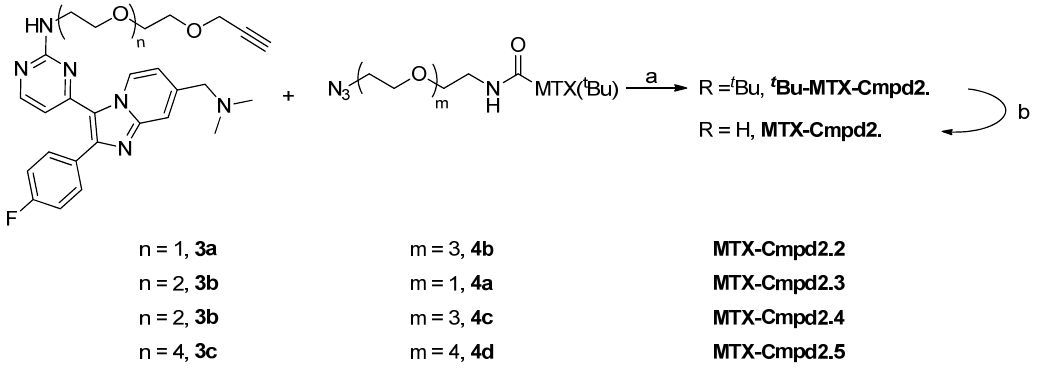
Scheme 3. Hüisgen 1,3-dipolar cycloaddition and deprotection to MTX-Cmpd2.2